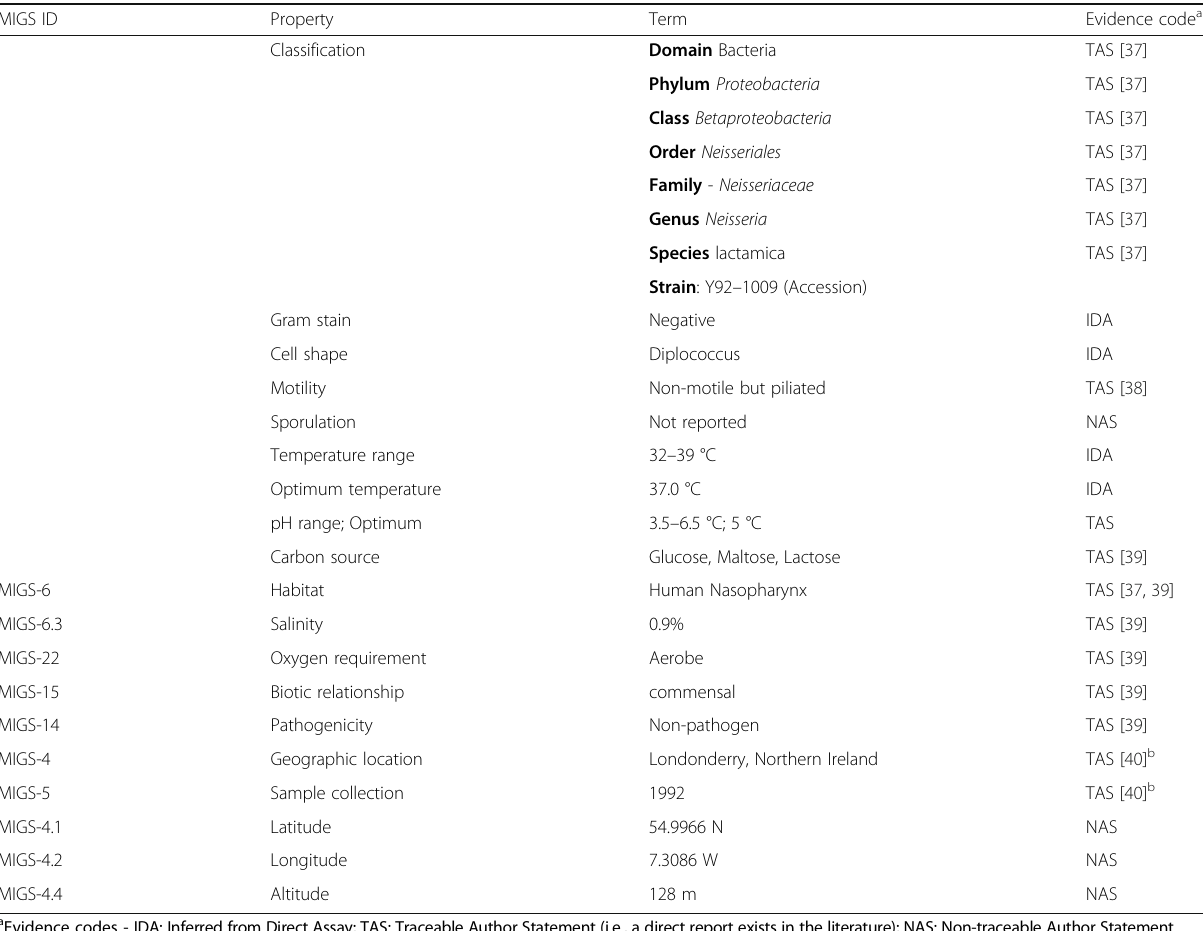
Table 1 Classification and general features of Neisseria lactamica strain Y92 – 1009 according to MIGS specification [36] MIGS